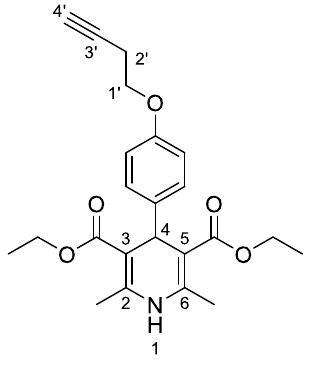
Figure 13. Chemical stucture of 3l .